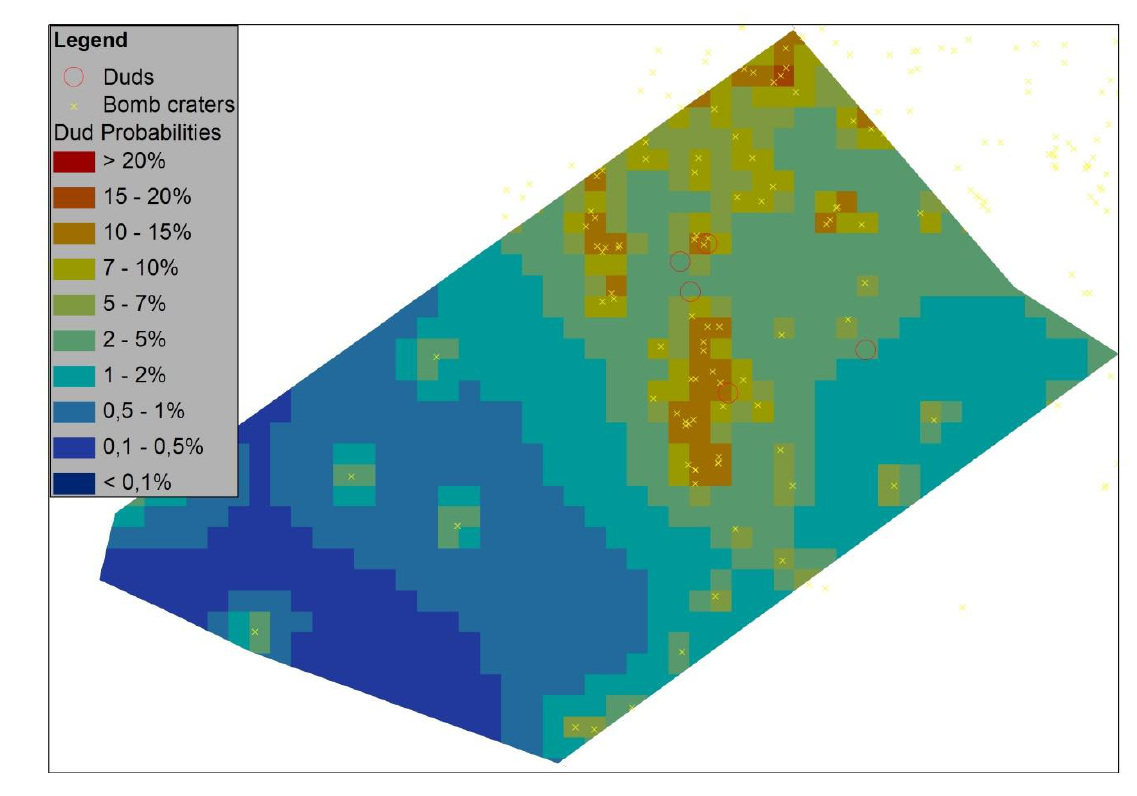
Figure 6. Dud probabilities for an area bombarded during the WWII. Yellow points are the known craters by photo interpretation, colored parcels indicate the calculated probabilities and the red circles are found duds during the